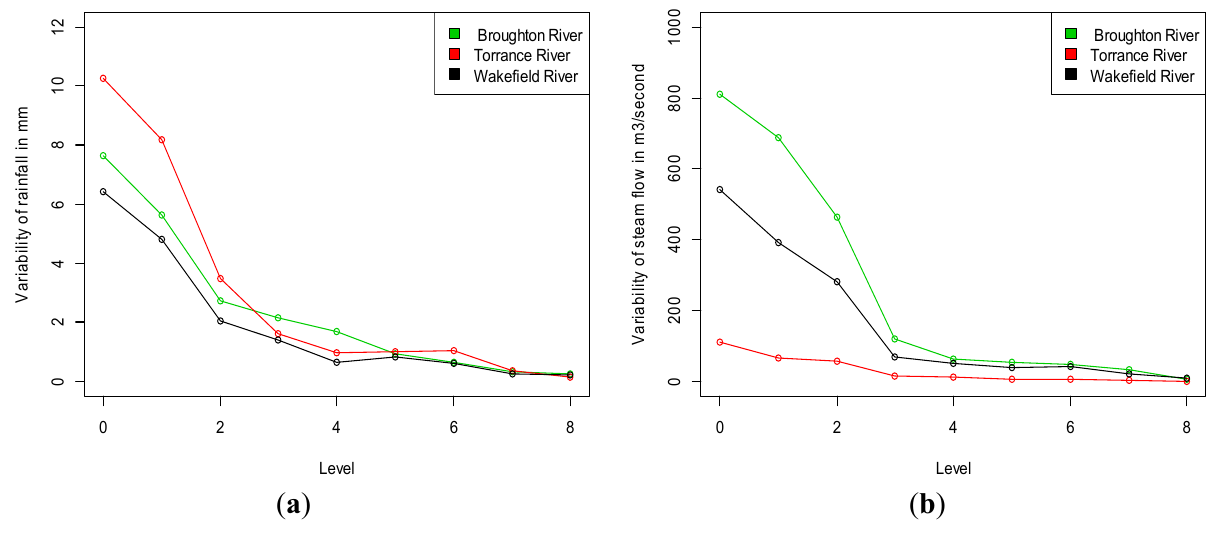
Figure 3. Standard deviations of wavelet coefficients of rainfall and stream flow from level 0 to 8. ( a ) Rainfall; ( b ) Stream flow.